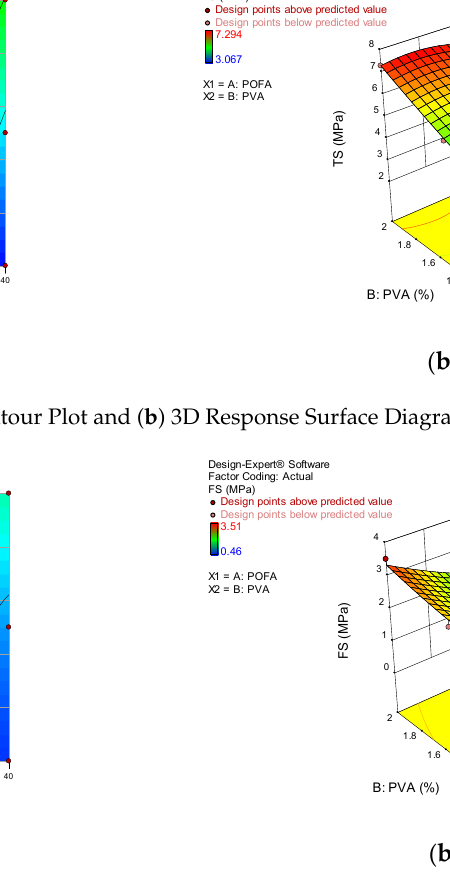
Design-Expert® Software Factor Coding: Actual TC (%) Design points above predicted value Design points below predicted value 6.6